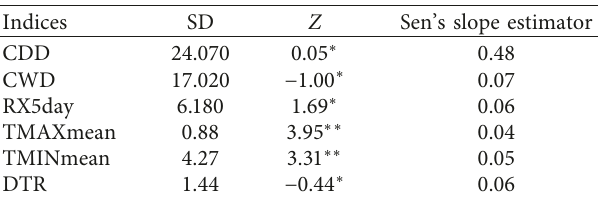
Figure 10: Ensemble interannual variability of the standardized precipitation anomaly (PRCPTOT) extreme over Addis Ababa (a), Jimma (b), and Combolcha (c) under RCP4.5 and RCP8.5 scenarios. Table 5: Summary of the MK test statistic for precipitation and temperature